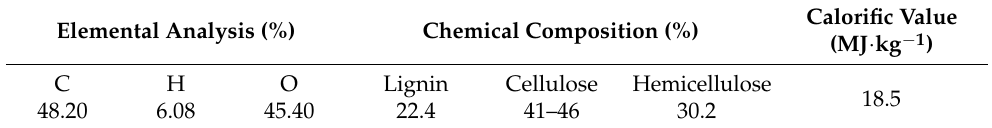
Table 2. Elemental analysis and chemical composition of the pine wood chips.